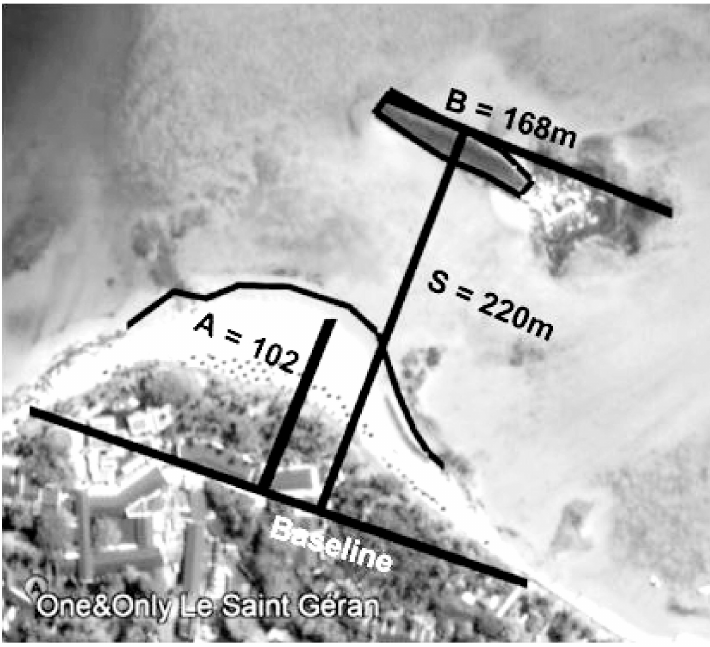
Figure 13. Offshore reef length ( B ), distance of reef offshore ( S ) and the salient apex width ( A ) relative to the baseline for the salient at St